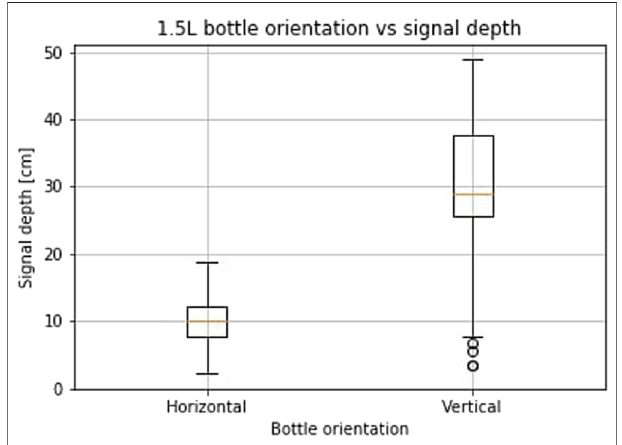
FIGURE 5 | Results obtained during object (bottle) orientation experiment of the controlled tests in the swimming pool. The orange line presents the median, the box is bounded by the fi rst (Q1) and third (Q3) quartile, the whiskers are bounded by the upper and lower data point